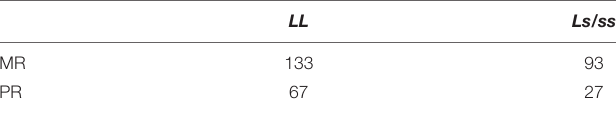
TABLE 1 | Distribution of 5-HTT genotypes across rearing groups. LL